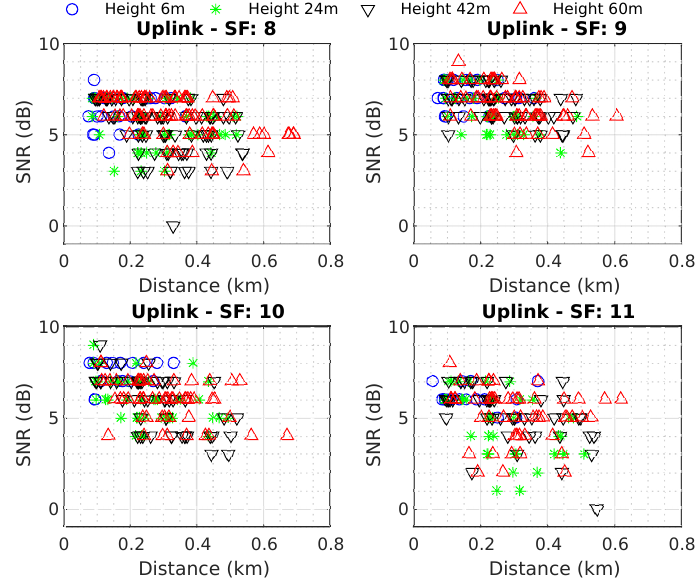
Figure 9. Uplink measured data SNR vs.